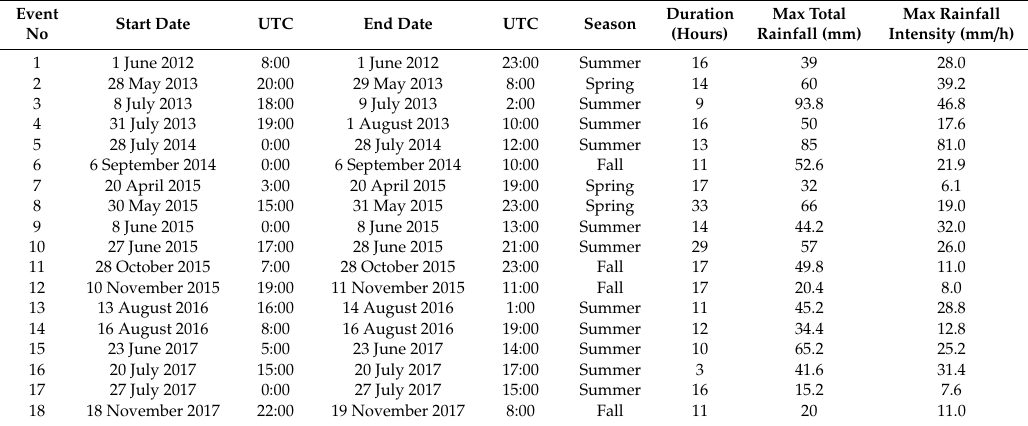
Table 2. Description of